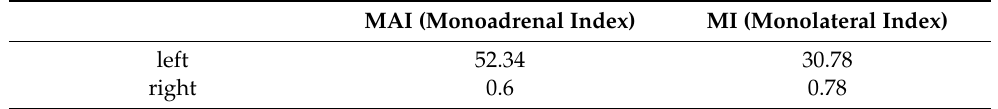
Table 3. Unconventional indices results Case